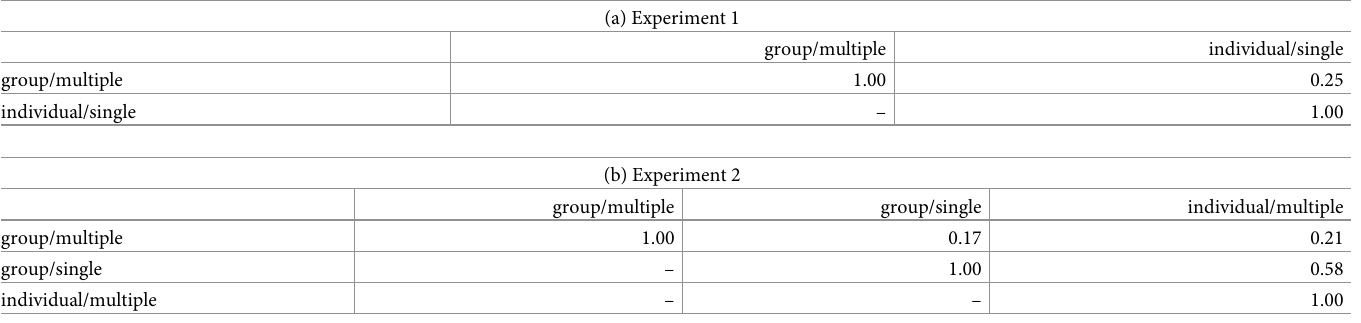
Table 4. Correlations between decisions. The table presents the correlation coefficient between decisions in the treatments implemented in the two experiments, Experi- ment 1 and Experiment